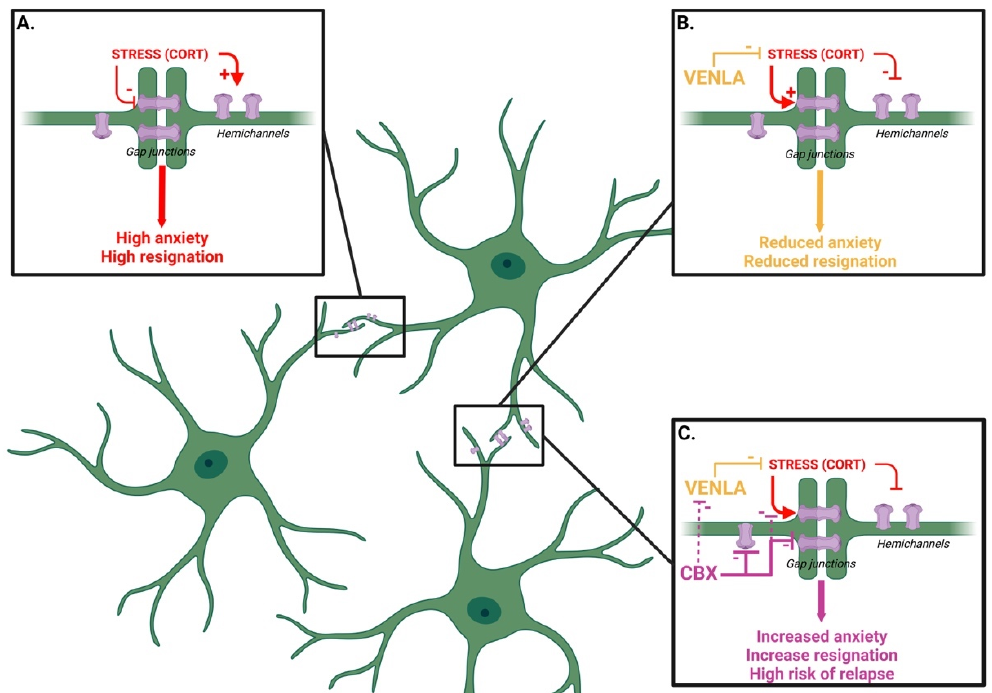
Figure 4. Schematic representation of the potential link between the astroglial connexins and the response to venlafaxine. In line with the literature, chronic stress (modeled here by the long-term exposure to corticosterone, CORT) is believed to block astroglial gap junctions (GJs) while maintaining hemichannels (HCs) opened. This configuration generates a high level of anxiety and resignation ( A ) suggesting that the impairment of GJ is sufficient to induce a depressive-like phenotype regardless of the functional status of the HCs. On the contrary, the long-term treatment with the antidepressant venlafaxine, either in direct opposition to CORT or by direct modulation of Cx, increases GJ and decreases HC expression/function. This configuration is associated with a reduced level of anxiety and resignation ( B ). The addition of the Cx blocker carbenoxolone (CBX) attenuates the response to venlafaxine and increases the risk of relapse after treatment withdrawal. Although CBX is not selective to GJs or HCs, this effect could result from direct inhibitory action on GJs (purple arrow). An interaction between CBX and venlafaxine (or CORT) catabolism (hatched purple arrow) is not excluded ( C ). Figure created with BioRender.com.